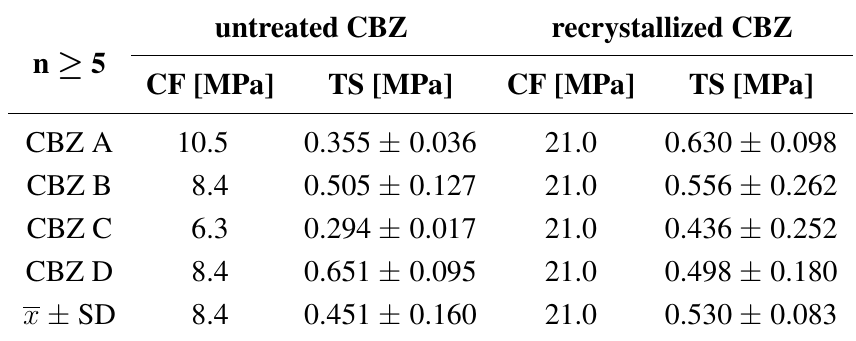
Table 2. Compaction force (CF) and tensile strength (TS) of untreated and recrystallized CBZ samples. Compacts were of fixed porosity.